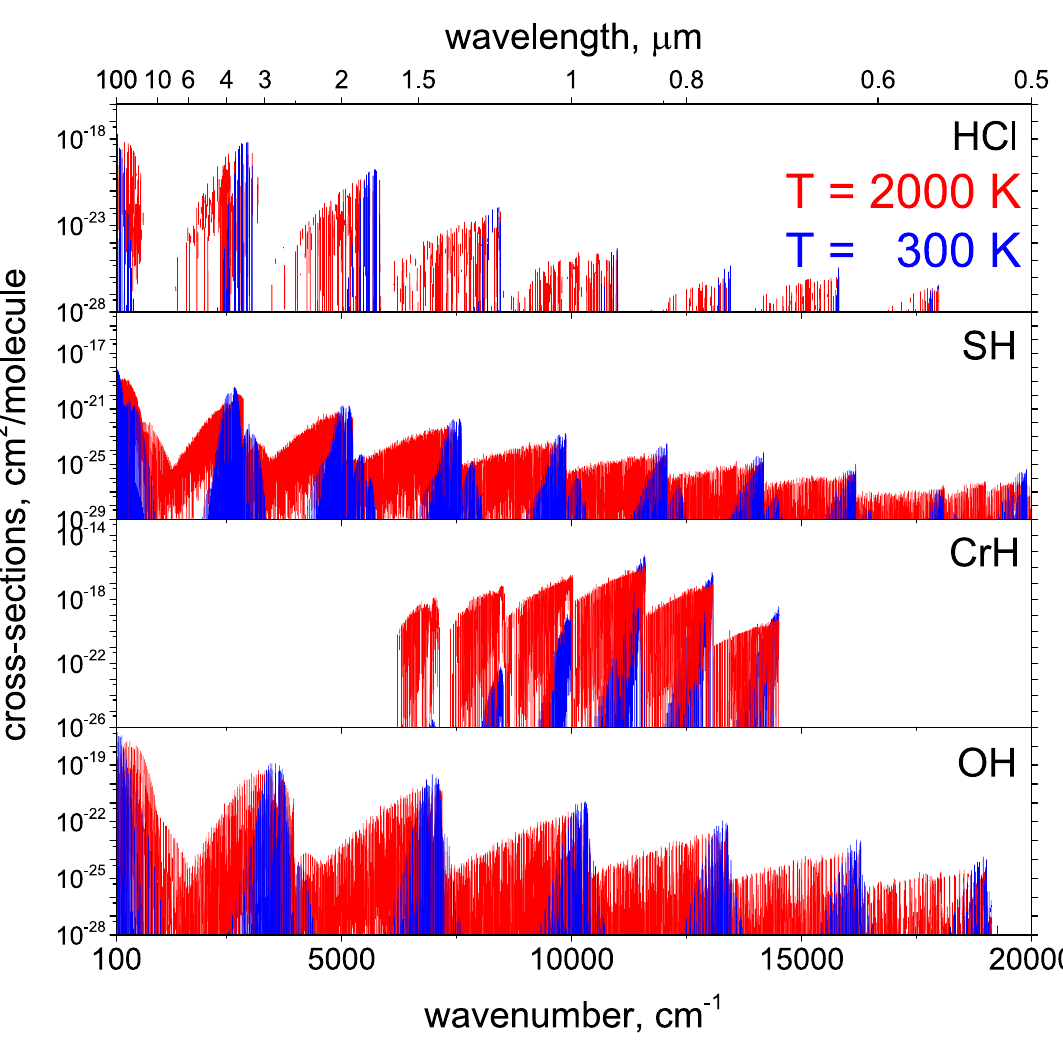
Figure 8. Cross sections for monohydrides: an empirical list due to Li. et al. [86] for HCl, an ExoMol line list for mercapto radical SH [74], chromium hydride [91]. The OH data are taken from HITEMP [4].